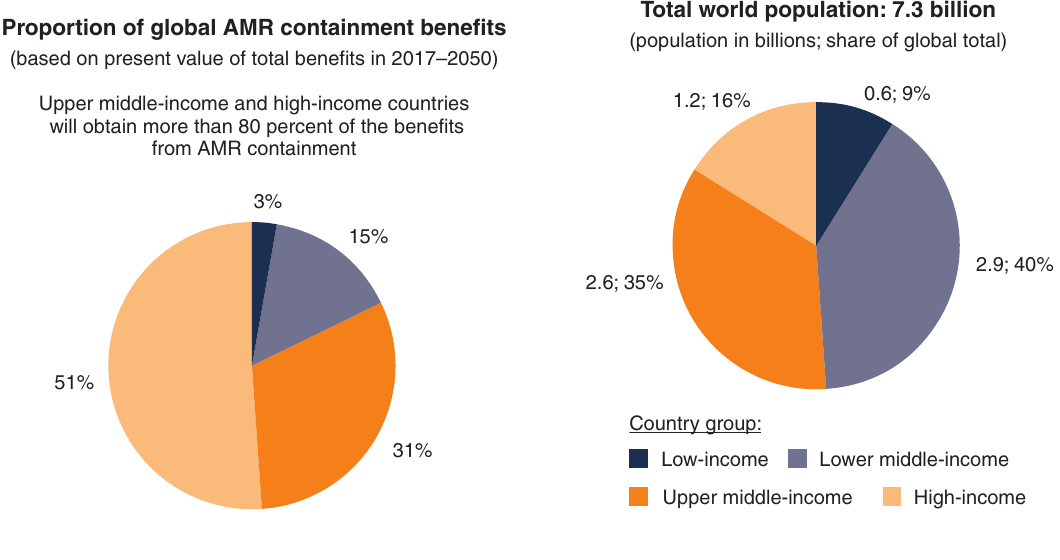
FIGURE ES3. High-Income and Upper Middle-Income Economies Stand to Benefit the Most from AMR Containment, Both in Absolute and per Capita